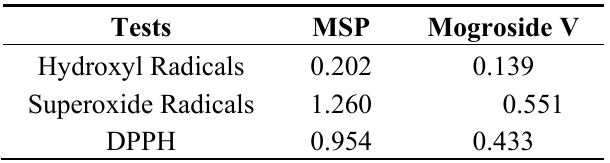
Table 1. IC values of free radical scavenging tests a 50